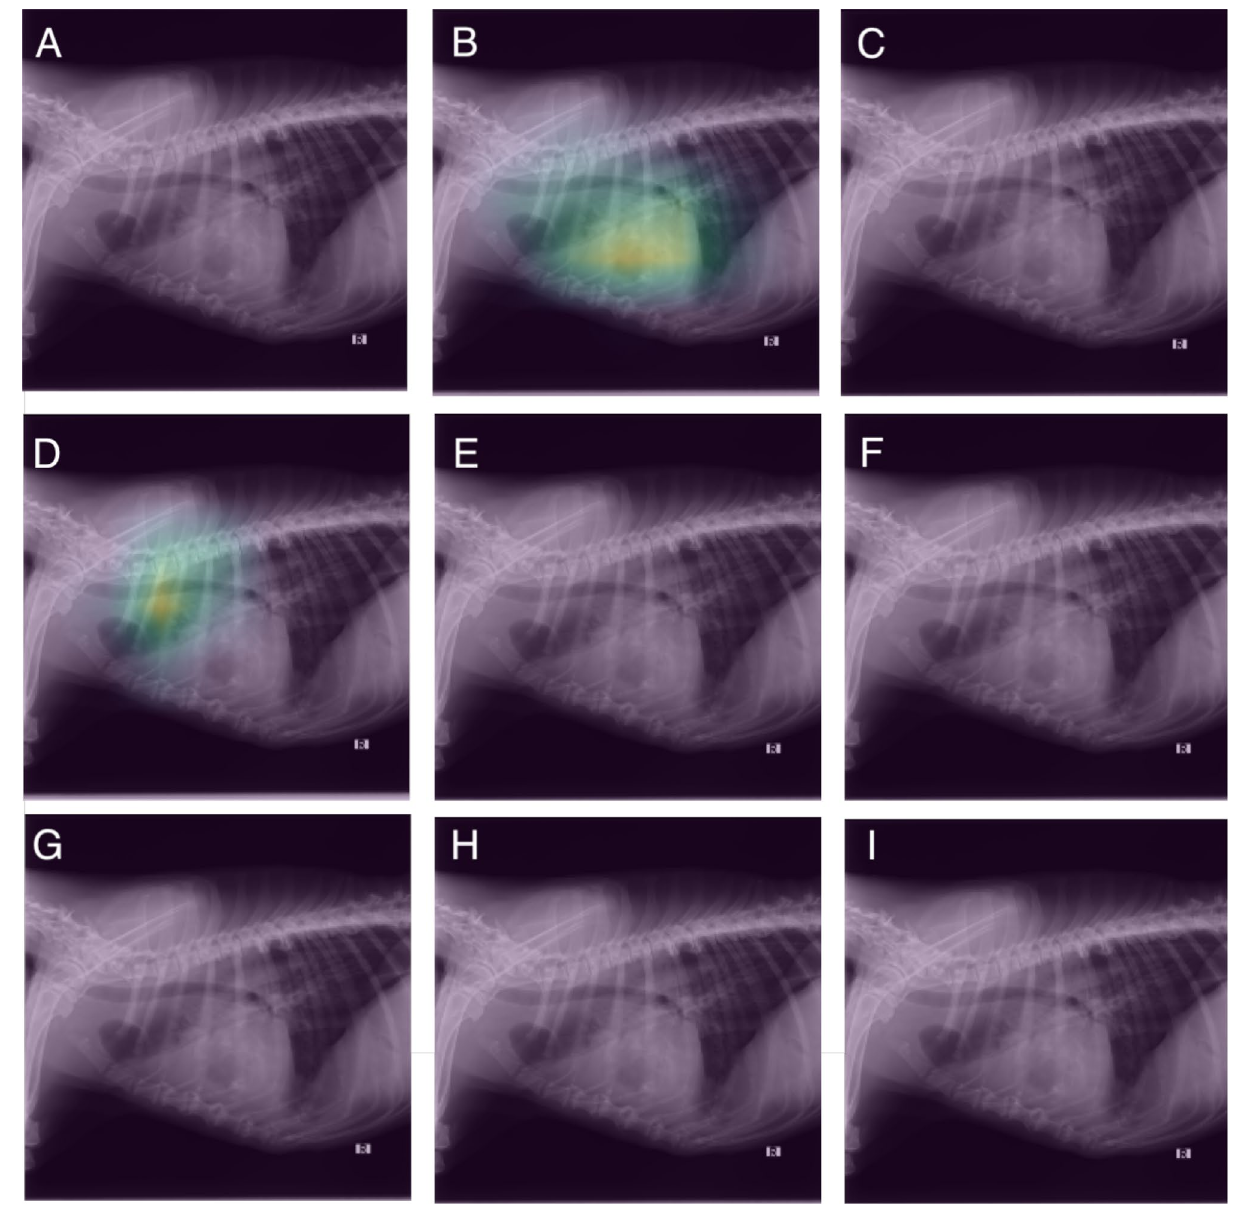
Figure 1. Visual assessment of the ResNet-50 classification results of a radiograph of a dog showing an alveolar pattern in the cranial lung lobe. The activations of the last layer are visualized superimposed on the radiographs. Each image corresponds to the activations for a specific radiographic finding. The alveolar pattern was correctly identified by the model (B) however the model also falsely identified the presence of a mass (E). (A) Original image, (B) alveolar pattern, C bronchial pattern, (D) cardiomegaly, (E) mass, (F) interstitial pattern, (G) pleural effusion, (H) pneumothorax, (I)